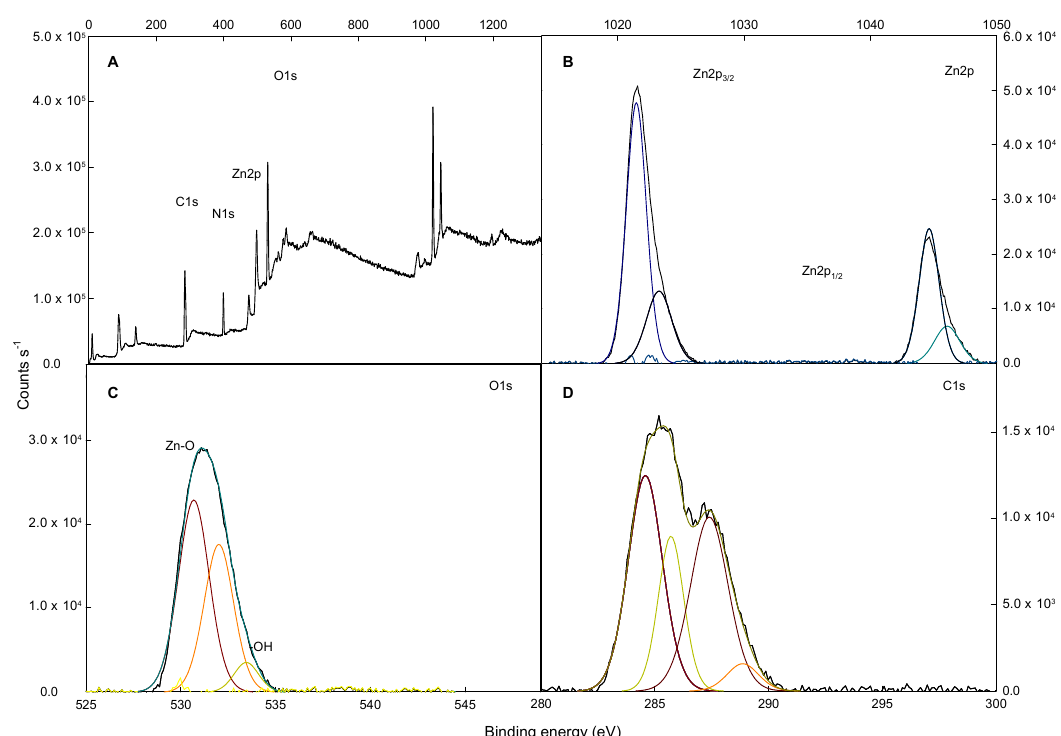
Figure 3. XPS spectra of SF/ZnO sample: ( A ) survey spectrum, ( B – D ) high-resolution binding energy spectra of Ti2p, O1s, and C1s, respectively.